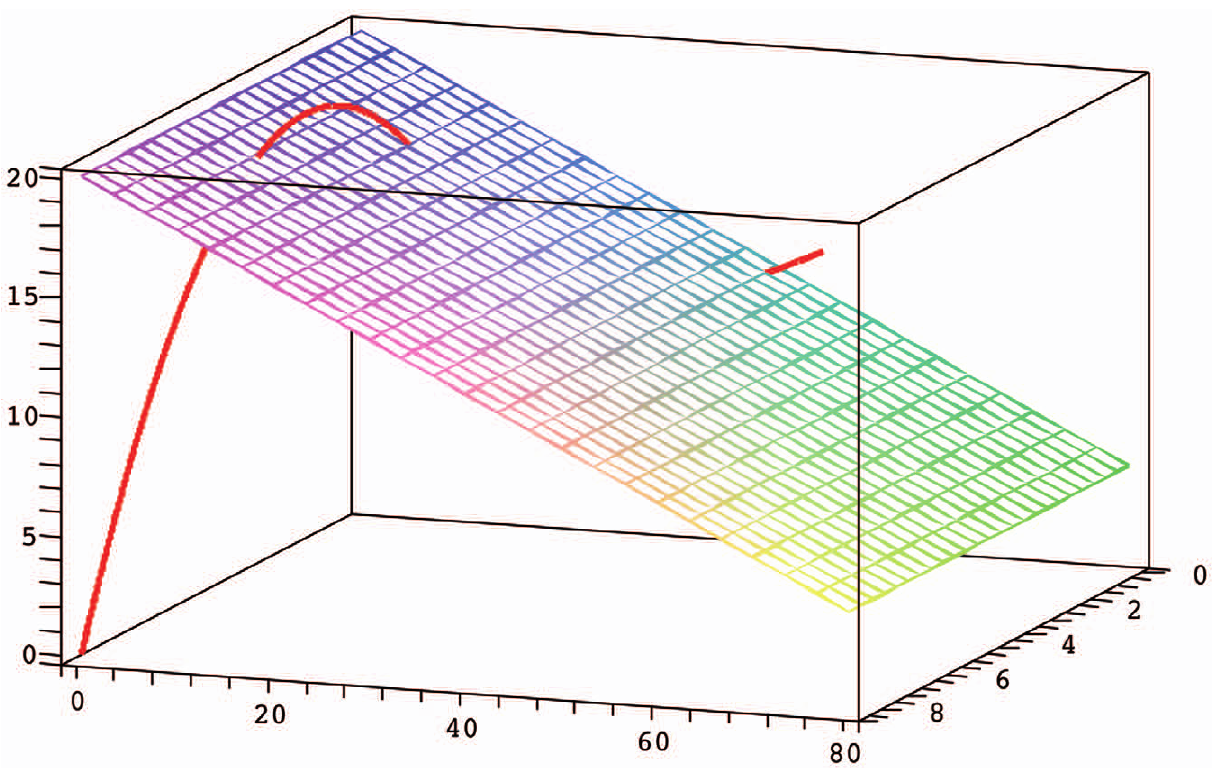
Figure 2. Number of equilibrium solutions for the Edelstein system by changing the value of conservation relation. Parameter values are k 1 ~ 8 : 5, k 2 ~ k 3 ~ k 4 ~ k 5 ~ 1, k 6 ~ 0 : 2 .